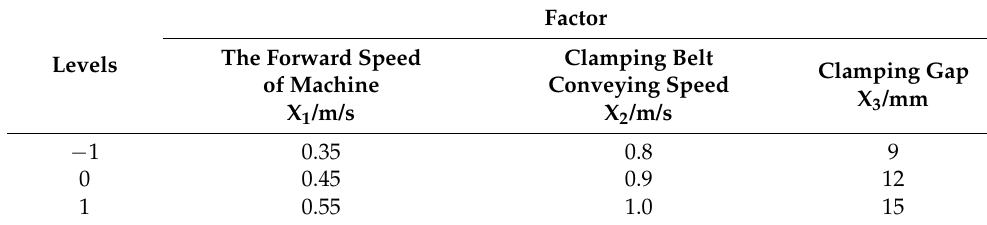
Table 4. Code schedule of factors and levels.